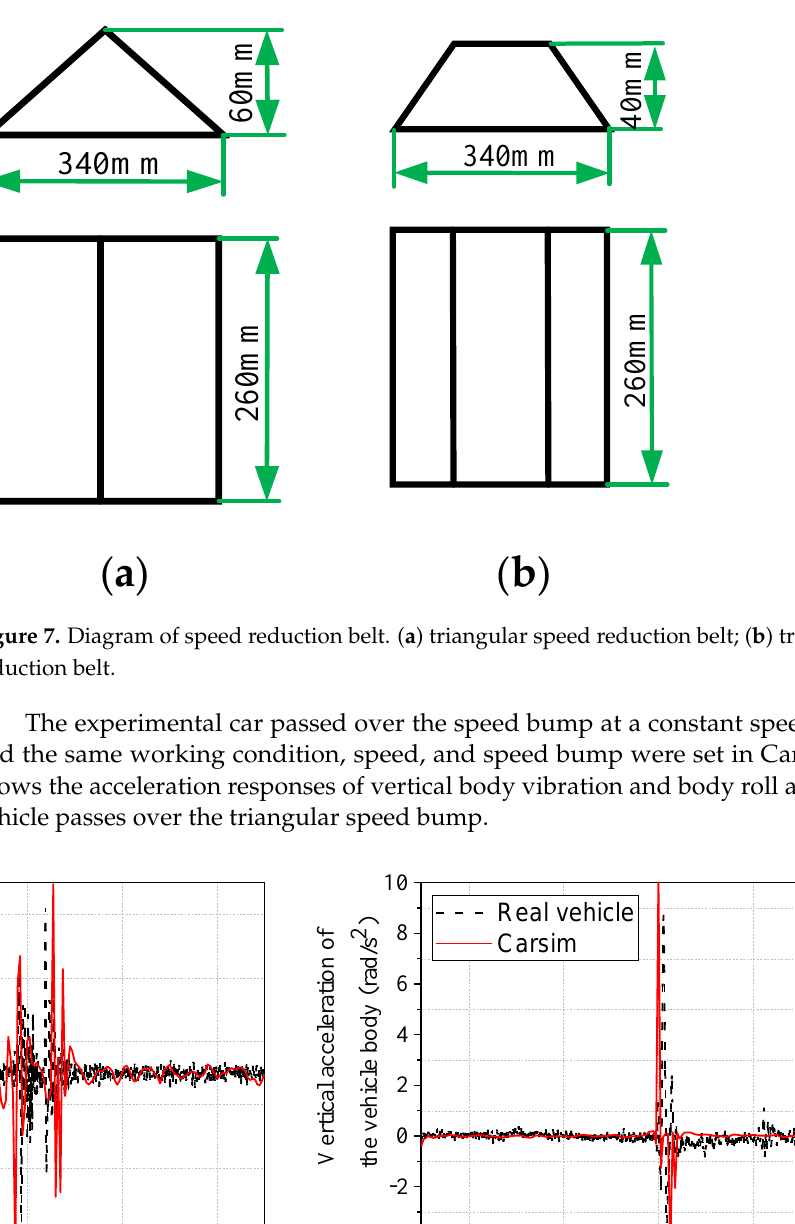
dynamic signal collector.